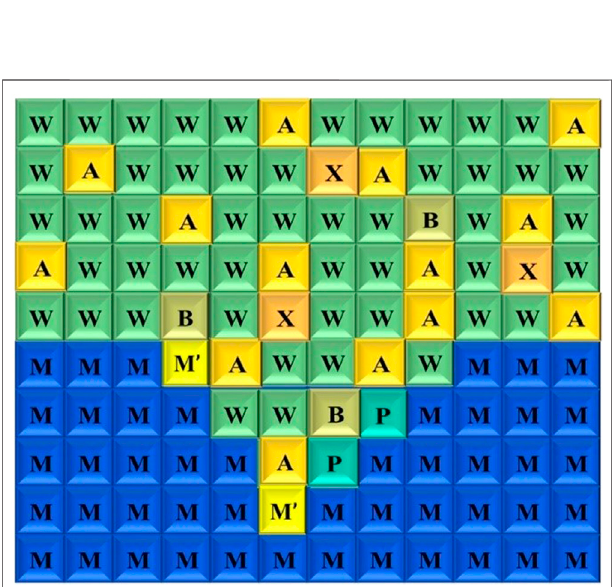
FIGURE 2 | Cell distribution